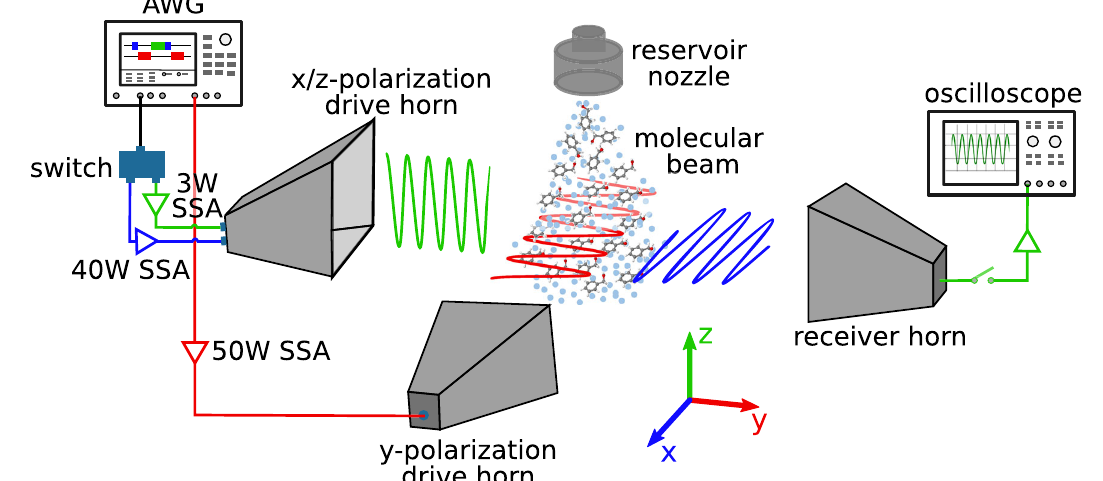
fi elds in the laboratory frame, which match the color code in the rotational level scheme as provided in Fig. 1. Each branch is equipped with a solid-state ampli fi er (SSA).Theampli fi edmicrowavepulsesaresequentiallybroadcastinthedesignated polarization directions to interact with the molecular jet using two dual- polarization horn antennae. The free induction decay (FID) of the resulting mole- cular response is collected in the z-polarization direction by a receiver horn and averaged by a fast digital